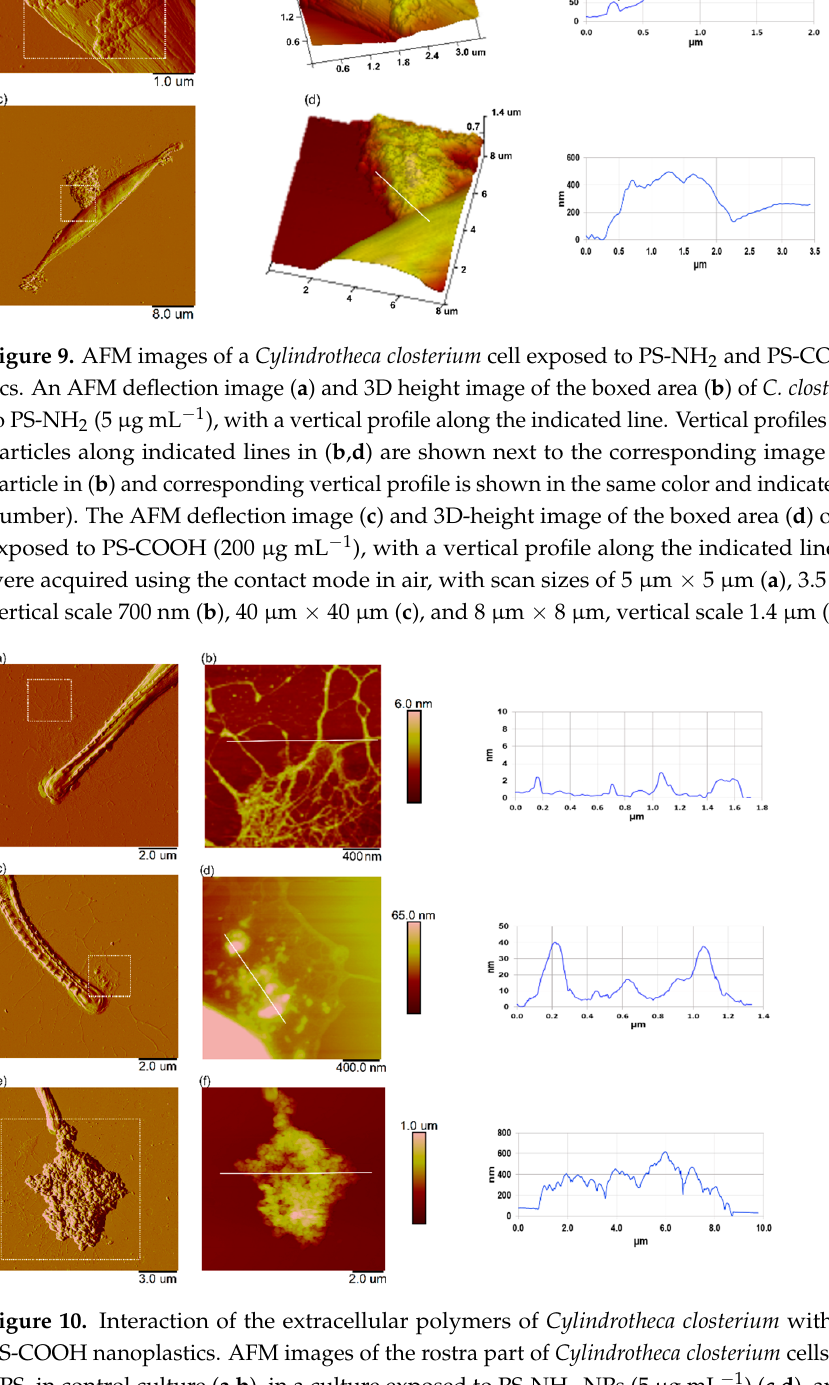
Figure 10. Interaction of the extracellular polymers of Cylindrotheca closterium with PS-NH 2 and PS-COOH nanoplastics. AFM images of the rostra part of Cylindrotheca closterium cells with excreted EPS, in control culture ( a , b ), in a culture exposed to PS-NH 2 NPs (5 µg mL − 1 ) ( c , d ), and in a culture exposed to PS-COOH NPs (200 µg mL − 1 ) ( e , f ). Images are acquired using the contact mode in air and are presented as the deflection data ( a , c , e ) and height data ( b , d , f ) of areas indicated with a box in the corresponding deflection images ( a , c , e ), with belonging vertical profiles along the indicated lines in ( b , d , f ). Scan sizes: 10 µm × 10 µm ( a ), 2 µm × 2 µm, vertical scale 6 nm ( b ), 10 µm × 10 µm ( c ), 2 µm × 2 µm, vertical scale 65 nm ( d ), 15 µm × 15 µm ( e ), and 10 µm × 10 µm, vertical scale 1 µm ( f ).